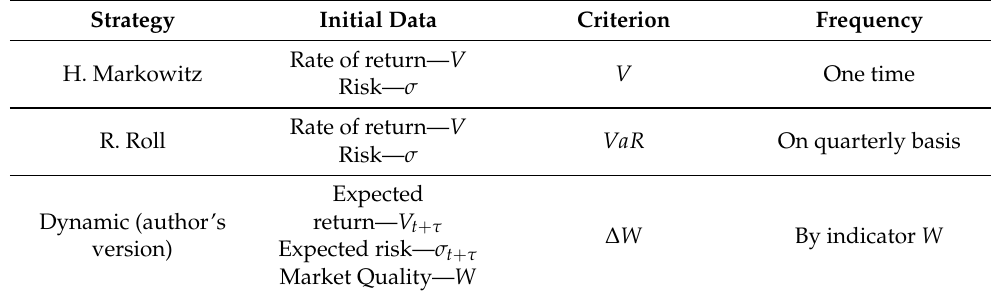
Table 7. Rebalancing criteria.